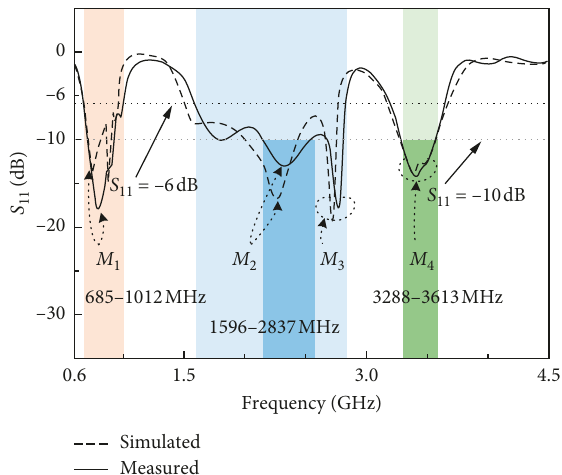
Figure 6: Simulated and measured S